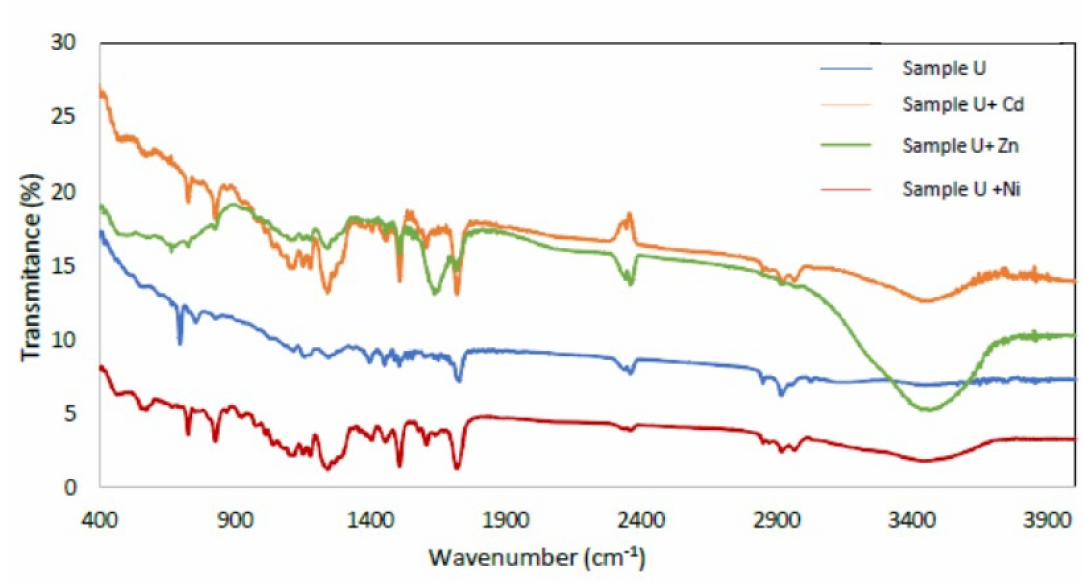
Figure 6. FTIR spectra of sample U, sample U with Cd adsorbed, sample U with Zn adsorbed and sample U with Ni